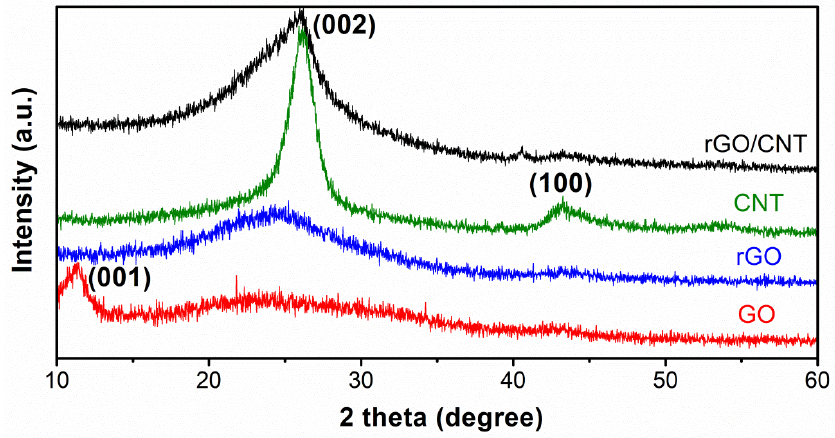
Figure 2. XRD scanned patterns of a) rGO/CNT paper, b) CNT, c) rGO, and d) GO,